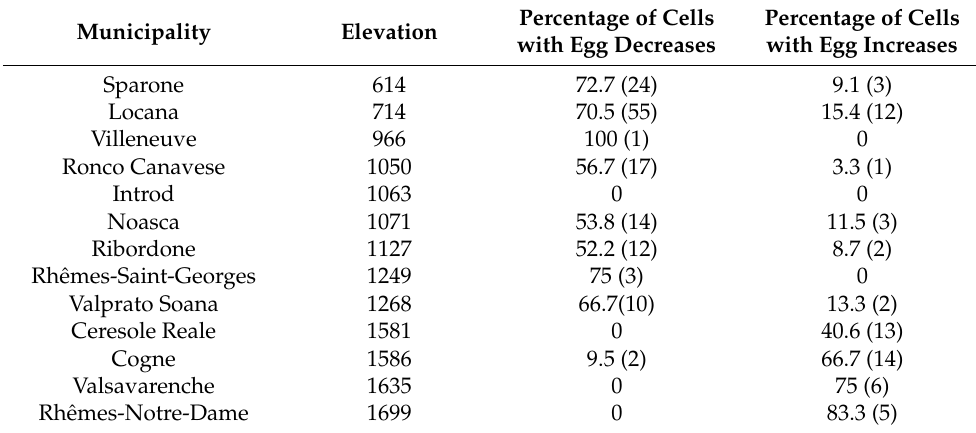
Table 5. Percentages of cells that showed a decrease or increase in egg abundance once the 50% Pelargonium reduction was